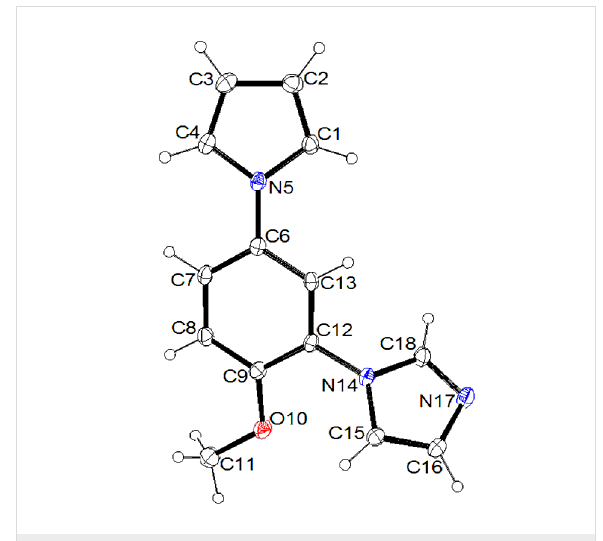
Figure 4: ORTEP diagram (30% probability) of 5d